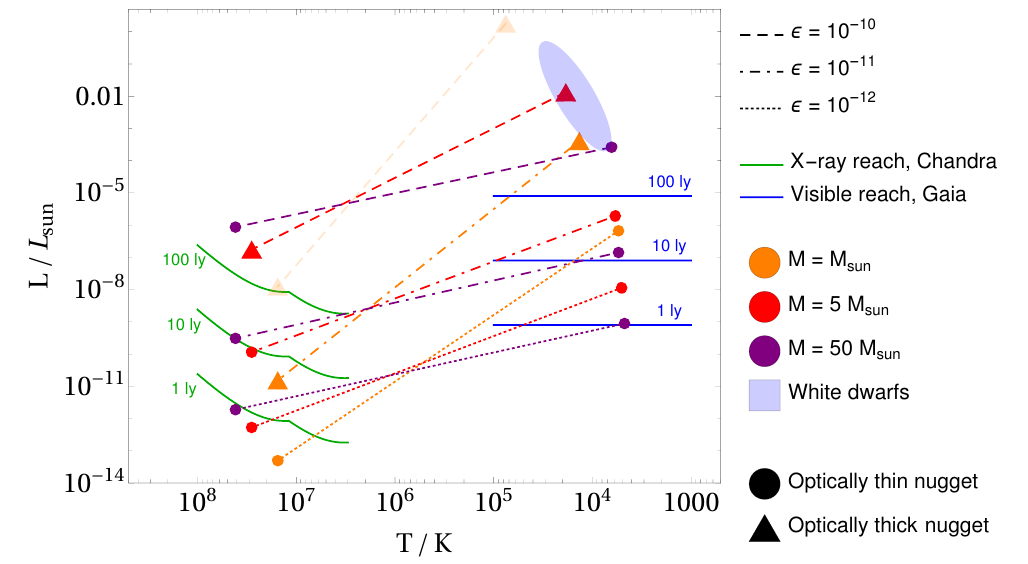
Figure 7 . A Hertzsprung-Russell diagram showing the dual signatures of our Mirror Star bench- marks. The plot shows luminosity against temperature, and each star is represented by two points connected by a line, each star having both a thermal emission in visible frequencies and an X-ray emission. The solid lines show the approximate distances up to which such objects could be ob- servable via di(cid:11)erent observational techniques. The observability of the visible frequency signal is compared to Gaia’s reach for objects of the same absolute magnitude, and the observability of the X-ray signal is compared to the limiting sensitivity of the Chandra X-ray Observatory. The kink in the X-ray sensitivity lines results from us selecting whichever of the two X-ray energy bands has a better sensitivity for a black body signature at that temperature. One of the points has been made transparent; this is the benchmark for which the luminosity of the nugget exceeds that of the star, signaling that our assumptions of ignoring the e(cid:11)ect of the SM nugget on the Mirror Star itself have broken